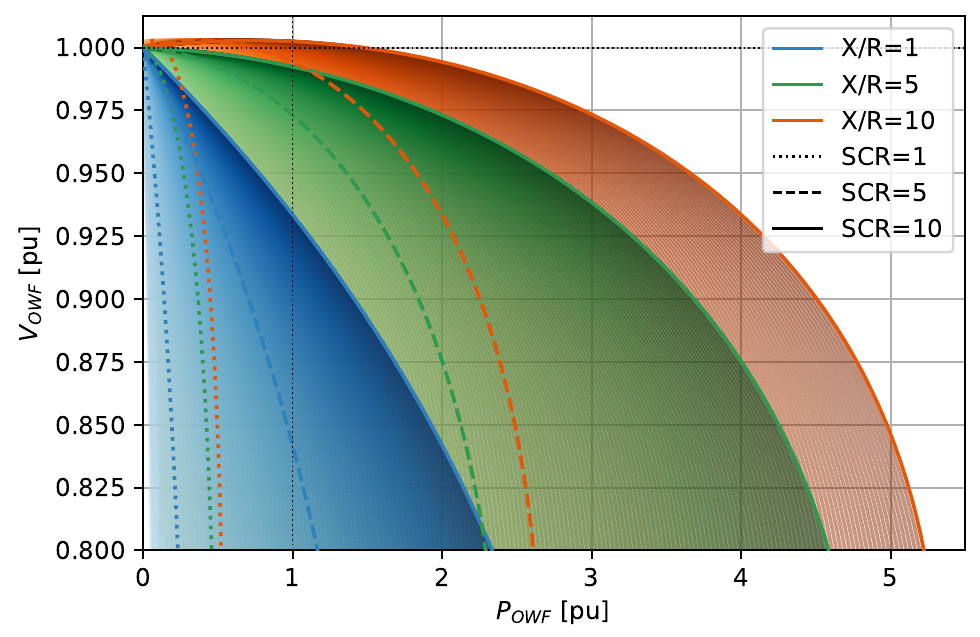
Figure 4. PV curves plotted for SCR , X / R ∈ { 1,5,10 } . The system is per-unitized, the voltage is only plotted to 0.8 pu, and there is no reactive power generation, i.e., power factor = 1. The colors distinguish the X / R ratio; orange is the highest and blue the lowest. For each X / R ratio plotted, there is a dotted, dashed, and solid line. The solidity of the line indicates the corresponding relative grid strength. In this manner, the orange solid line represents the PV curve of a strong grid, and the blue dotted line represents the PV curve of a weak grid ( SCR = X / R = 10 and SCR = X / R = 1,